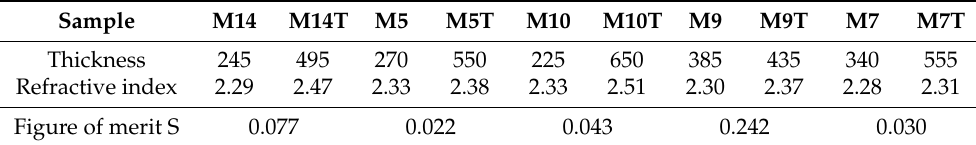
Table 2. Refractive index, film thickness, and figure of merit S obtained for the five chosen deposi- tion conditions.